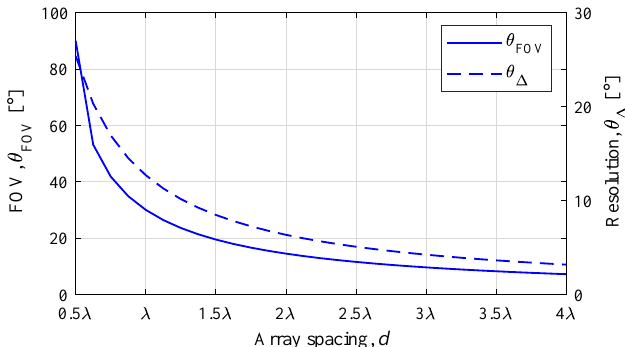
Figure 3. Field of view (FOV) and resolution according to array spacing d with K =